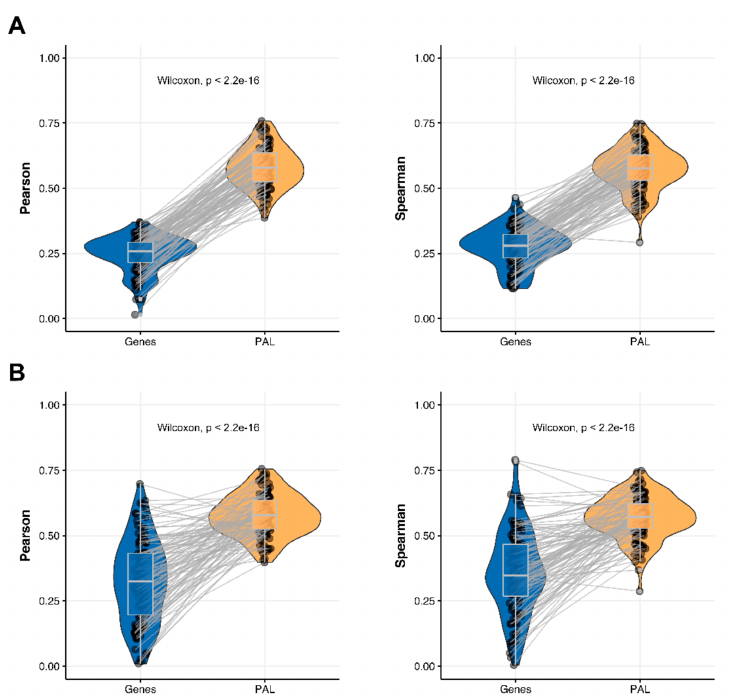
Figure 11. Paired gene-to-gene and PAL-to-PAL correlation between RNA and protein expression levels estimated within Lung Adenocarcinoma biosamples using Pearson ( left ) and Spearman ( right ) correlation coefficients for ( A ) the total set of genes and molecular pathways; ( B ) the set of drug target genes and molecular pathways